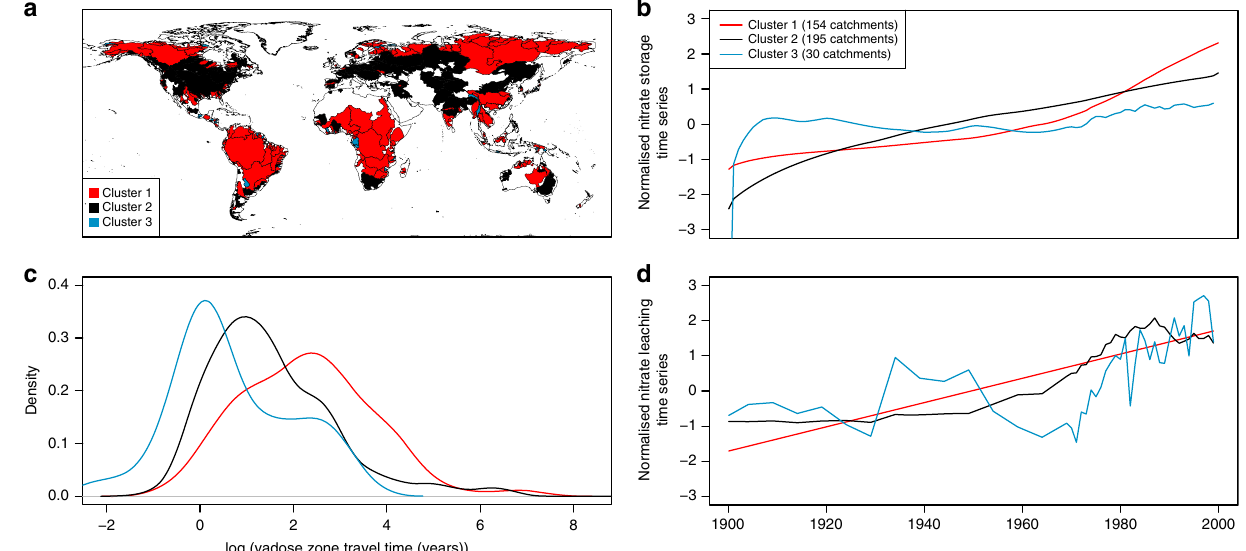
Fig. 4 Basin-scale nitrate storage trends. Spatial distribution of the nitrate storage clusters ( a ), nitrate storage cluster centroids ( b ), distribution of vadose zone travel times ( c ) and mean annual nitrate leaching input time series ( d ) for each